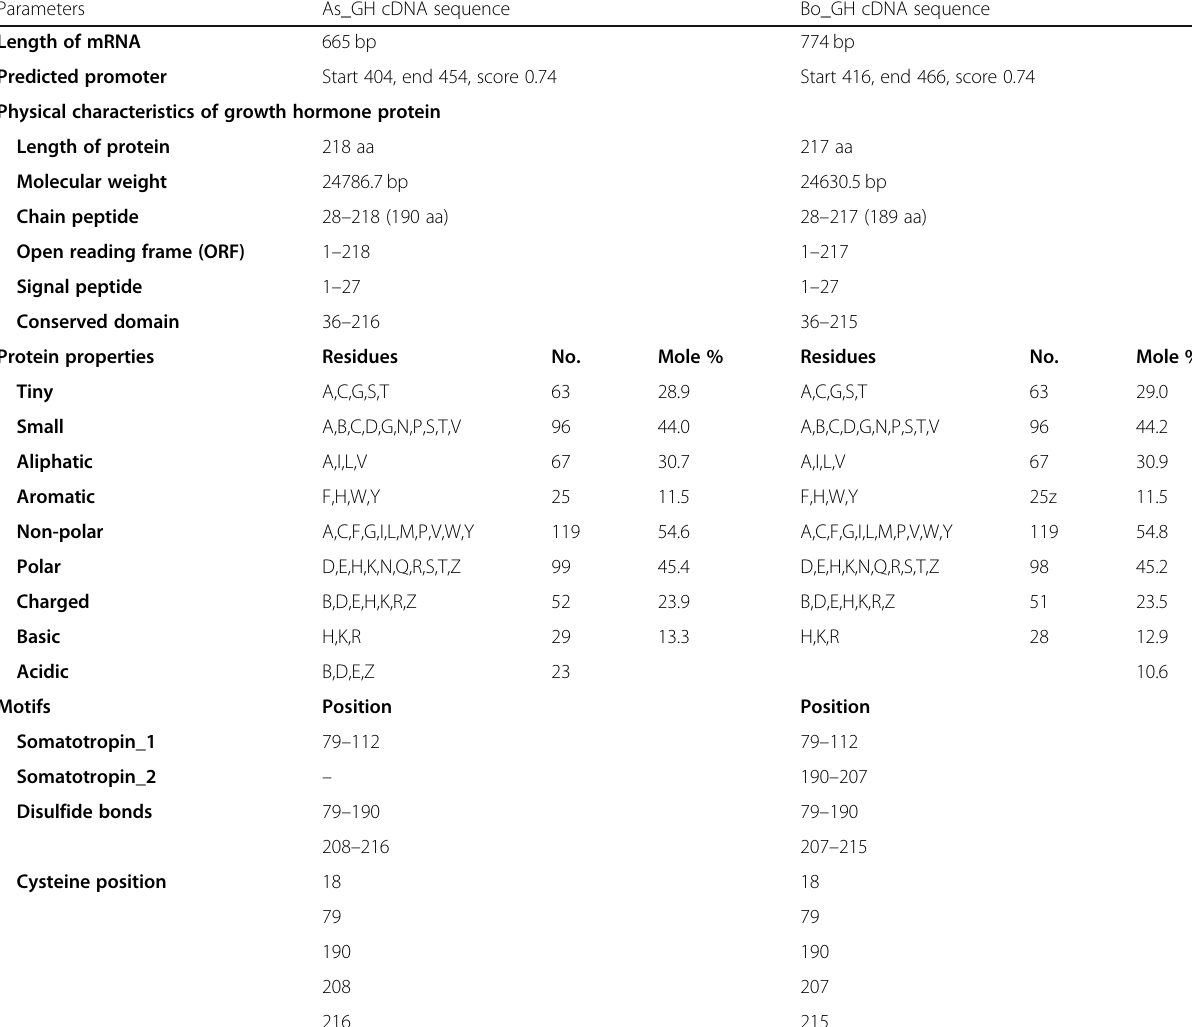
Table 3 Comprehensive summary of As_GH and Bo_GH annotations